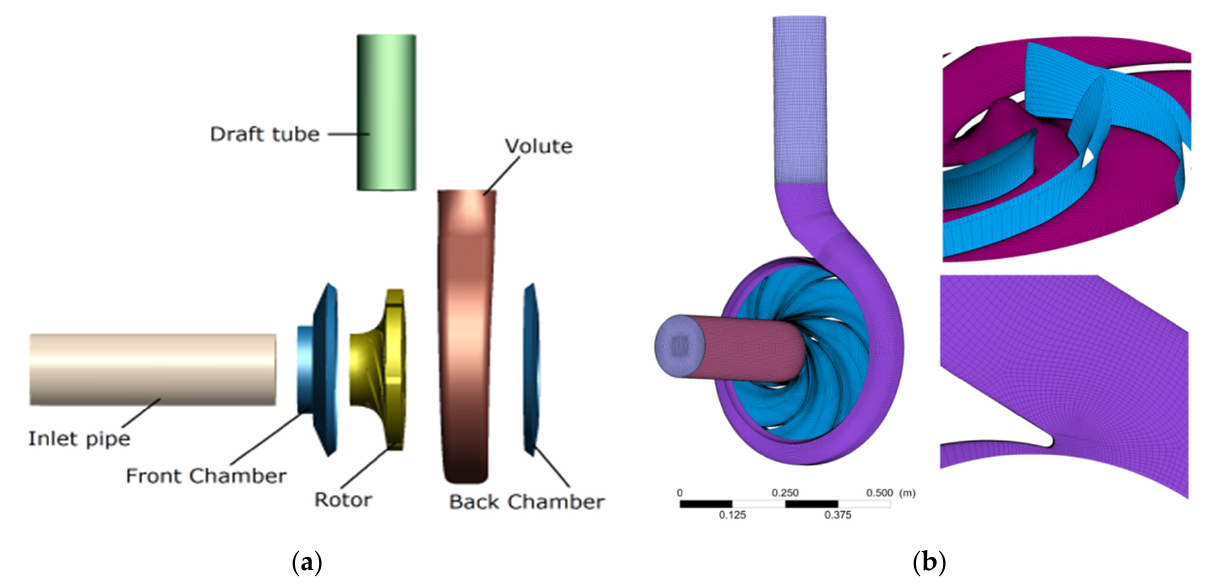
Figure 7. ( a ) 3D mode of whole flow domains; ( b ) meshing display.